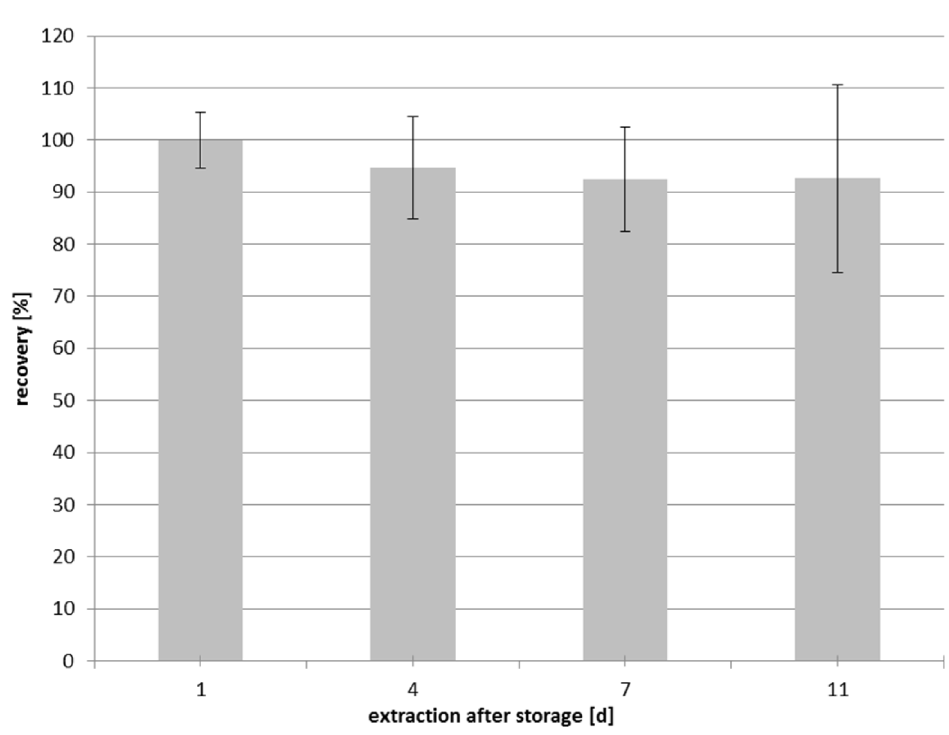
Fig 2. Stability of dried blood spots during storage ( –